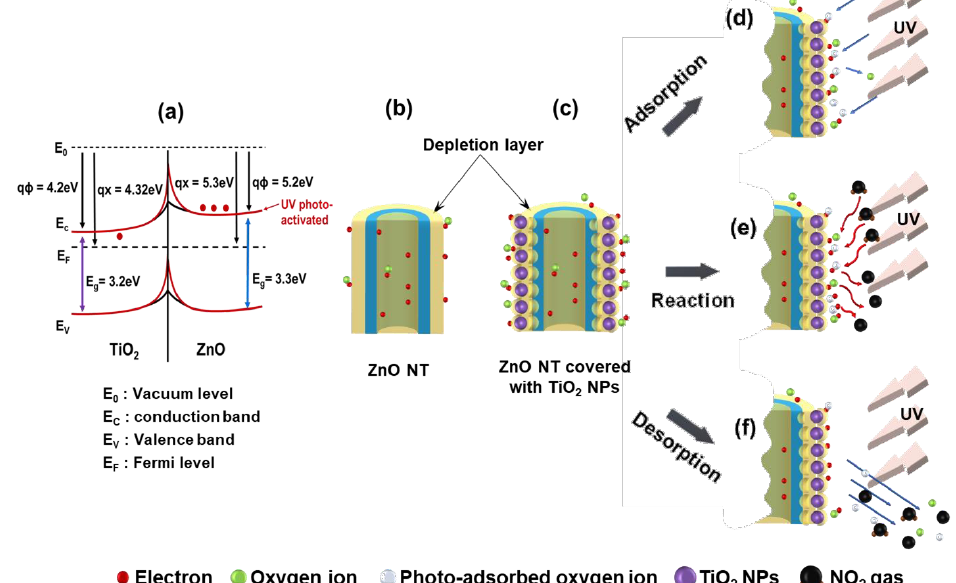
Figure 5. ( a ) Ideal band structure and electron transfer for ZnO and TiO 2 . ( b )-( f ) Schematic diagram of possible gas-sensing mechanism of photoactivated ZnO NTs covered with a TiO 2 NPs gas